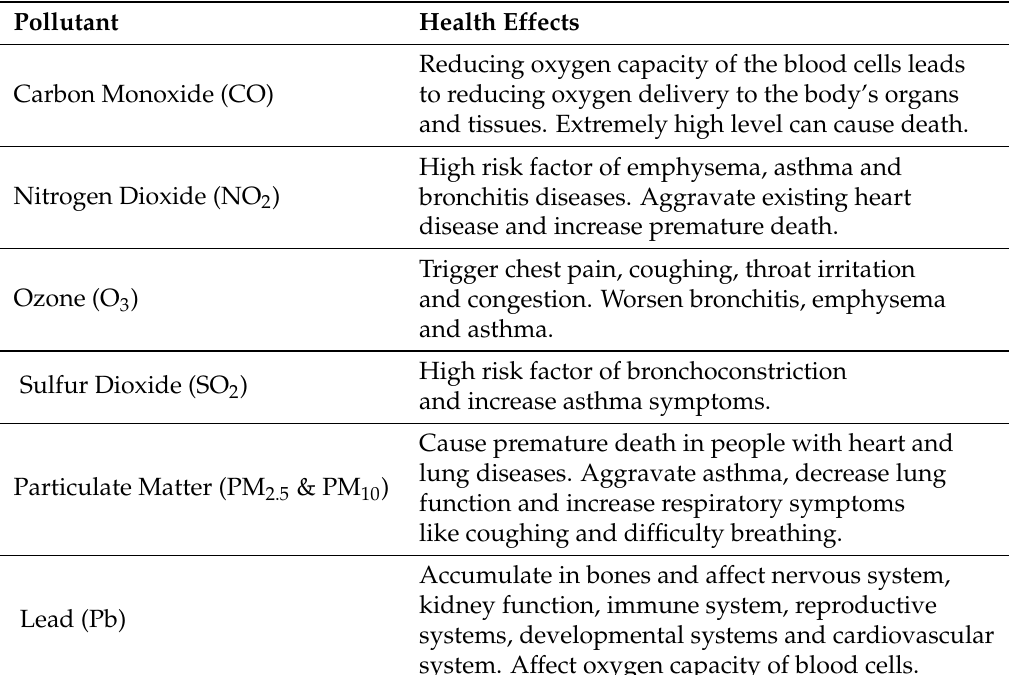
Table 2. The six common pollutants and their health